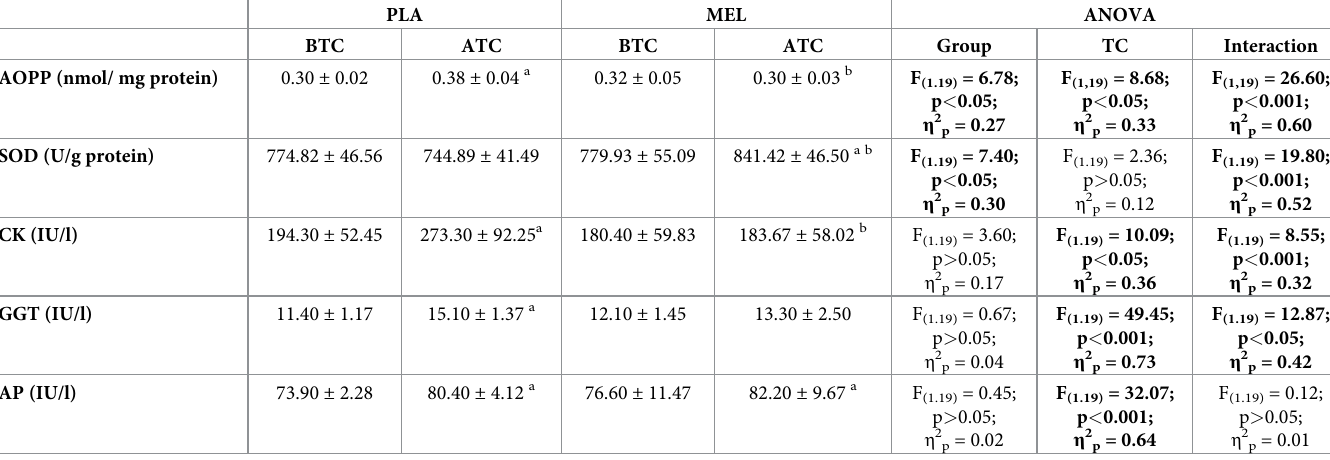
Table 2. Biochemical parameters measured before (BTC) and after (ATC) the training camp (TC) following melatonin (MEL) or placebo (PLA) ingestion. PLA MEL ANOVA BTC ATC BTC ATC Group TC